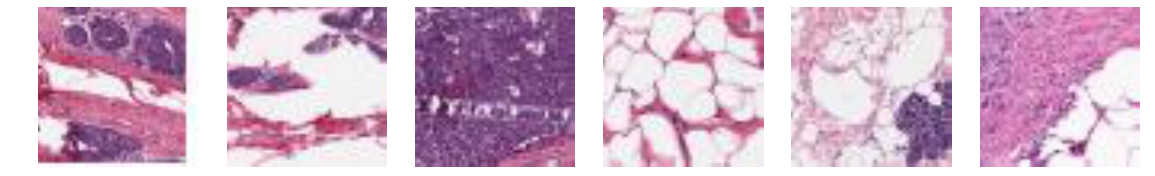
Figure 3. A sample of the ICD